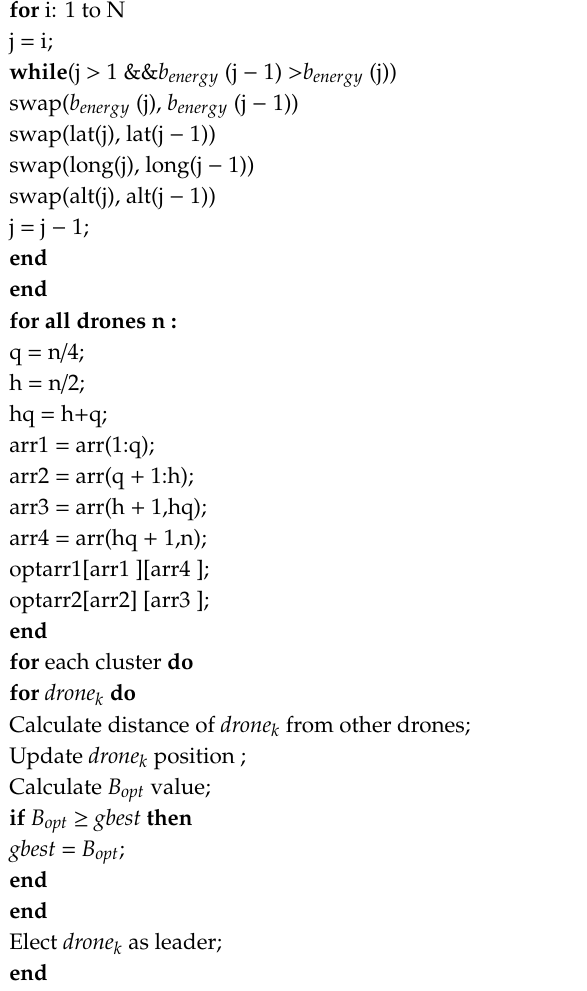
Algorithm 3. CLUSTER